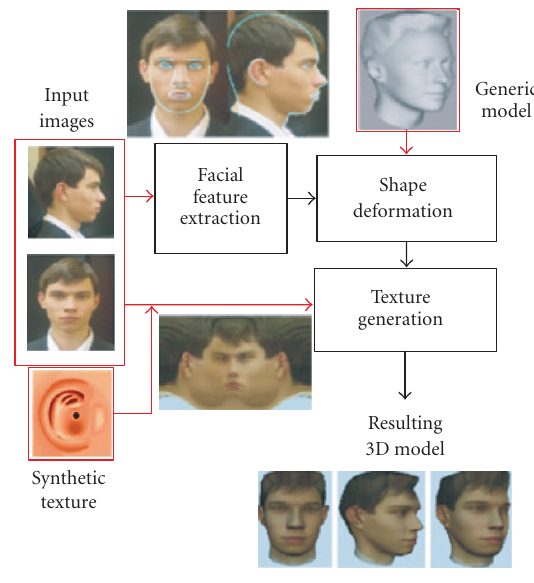
Figure 1: Overview of the proposed